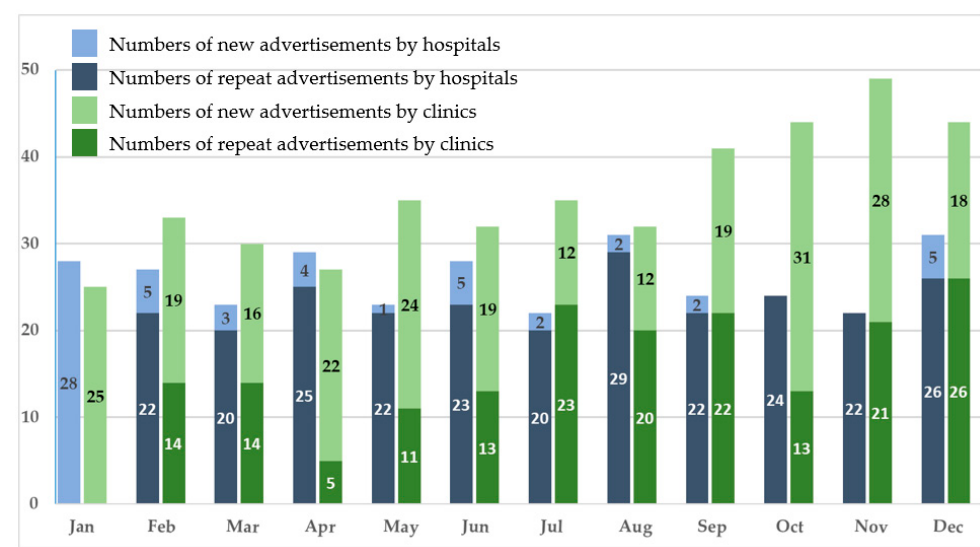
Figure 1. Family physician recruitment advertisements in the 2018 Taiwan Medical Journal.